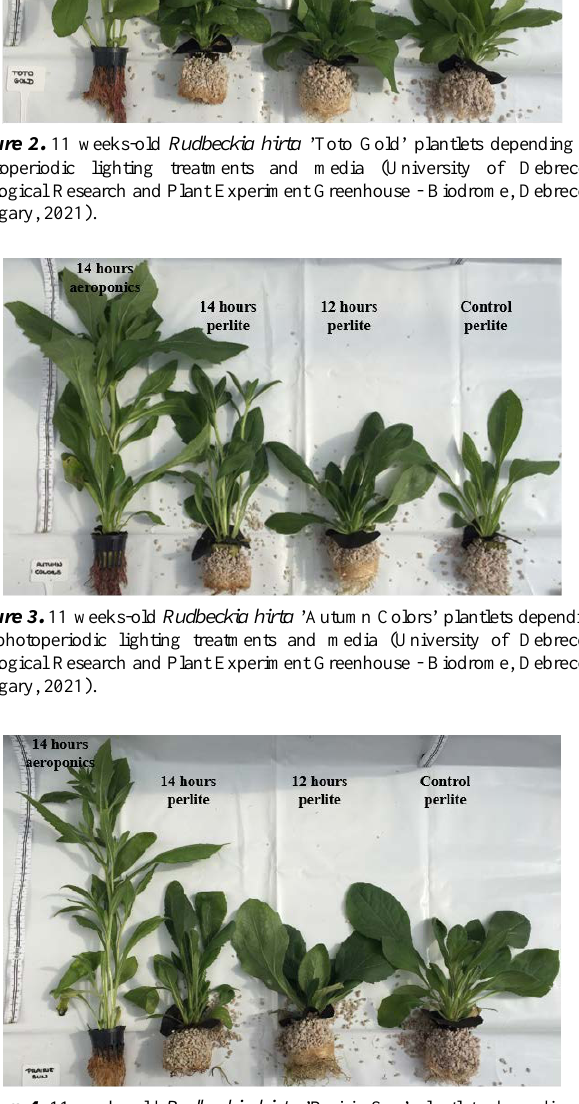
Figure 4. 11 weeks-old Rudbeckia hirta ’Prairie Sun’ plantlets depending on photoperiodic lighting treatments and media (University of Debrecen, Biological Research and Plant Experiment Greenhouse - Biodrome, Debrecen, Hungary,